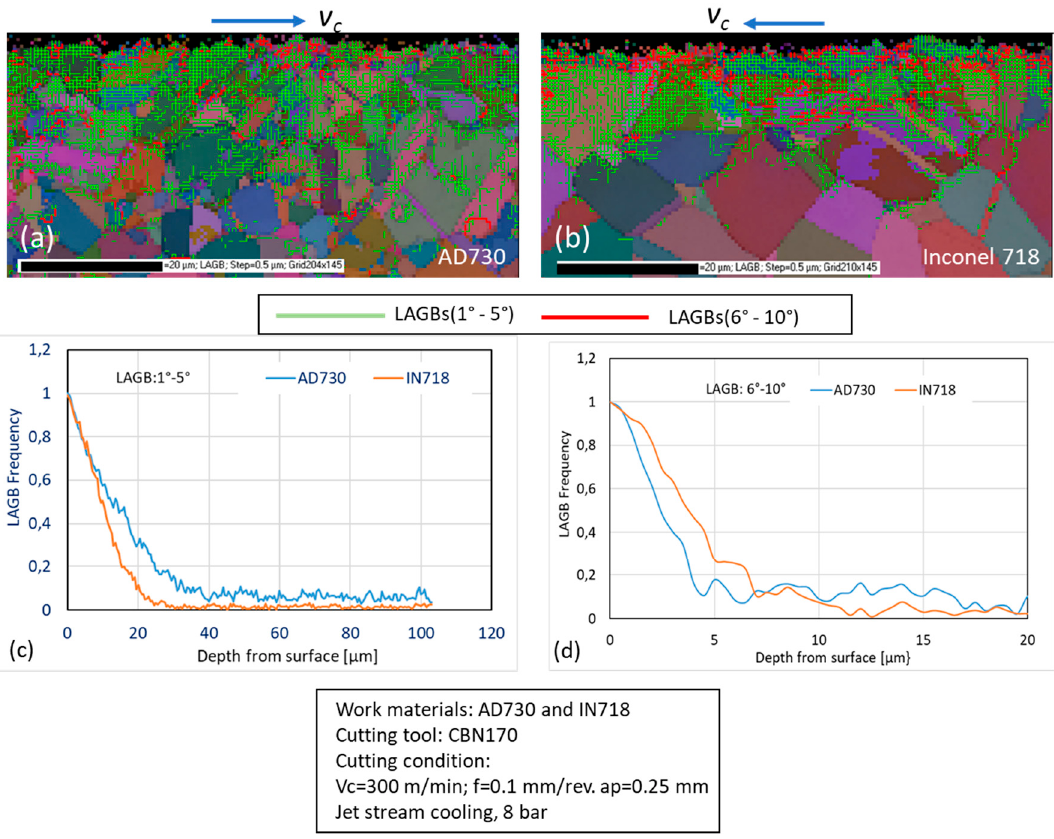
Figure 9. EBSD mapping of the subsurface deformation of ( a ) AD730 ® and ( b ) IN718 and the corresponding intensity level of low-angle grain boundaries (LAGBs) in the range of ( c ) 1–5° and ( d ) 6–10°.